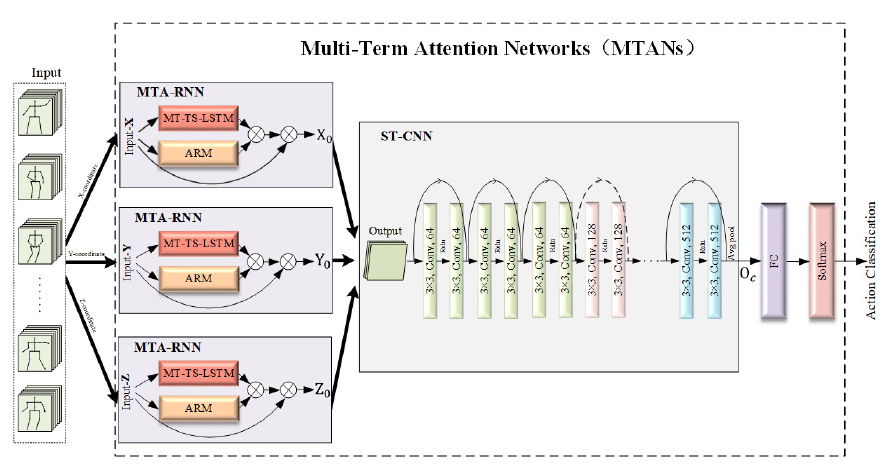
Figure 1. The structure of Multi-Term Attention Networks (MTANs), includes the Multi-Term Attention Recurrent Neural Network (MTA-RNN) and Spatial-Temporal Convolutional Neural Network